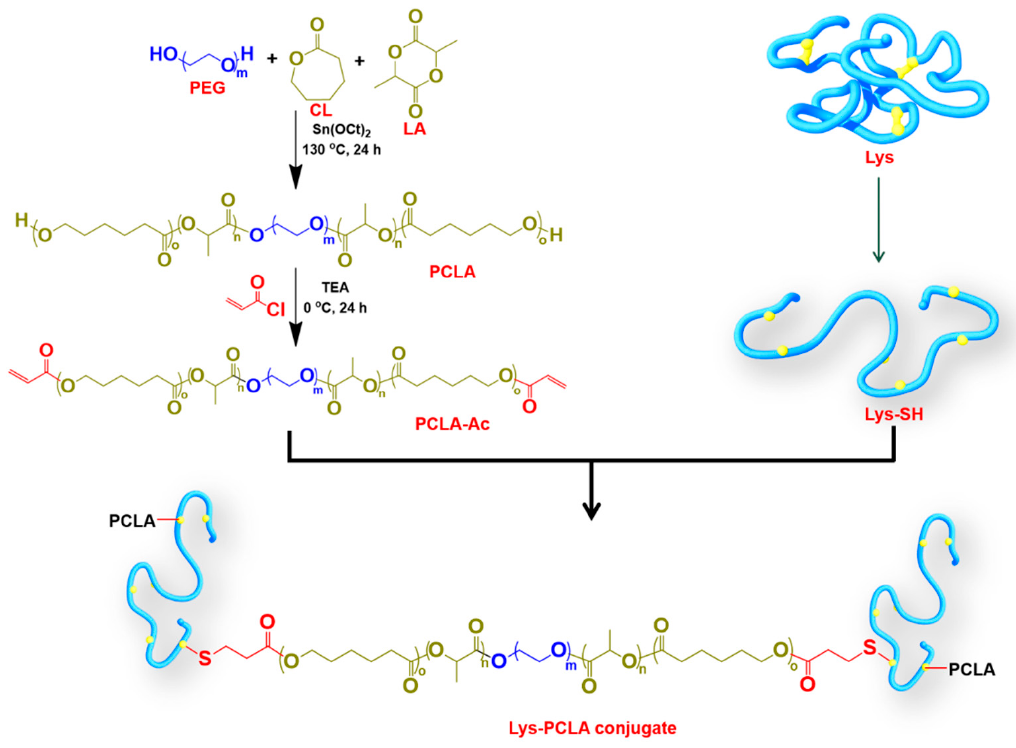
Figure 1. Synthesis of Lys-PCLA conjugate.